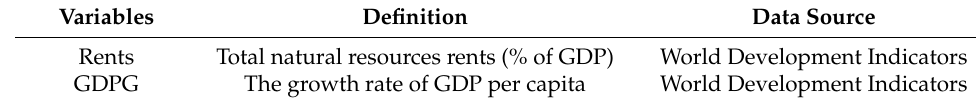
Table A1. Data Sources and Definition of Variables.